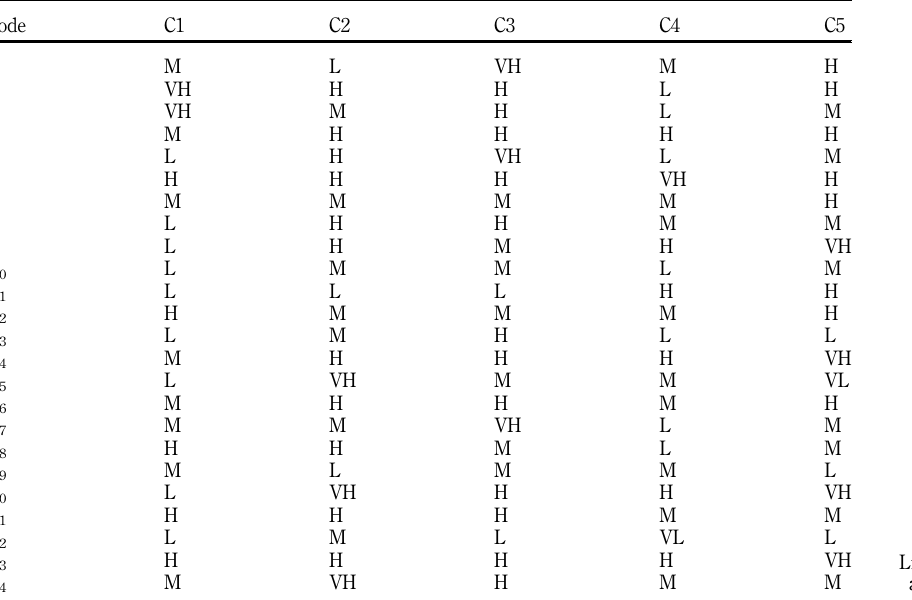
Table A8. Linguistic variable